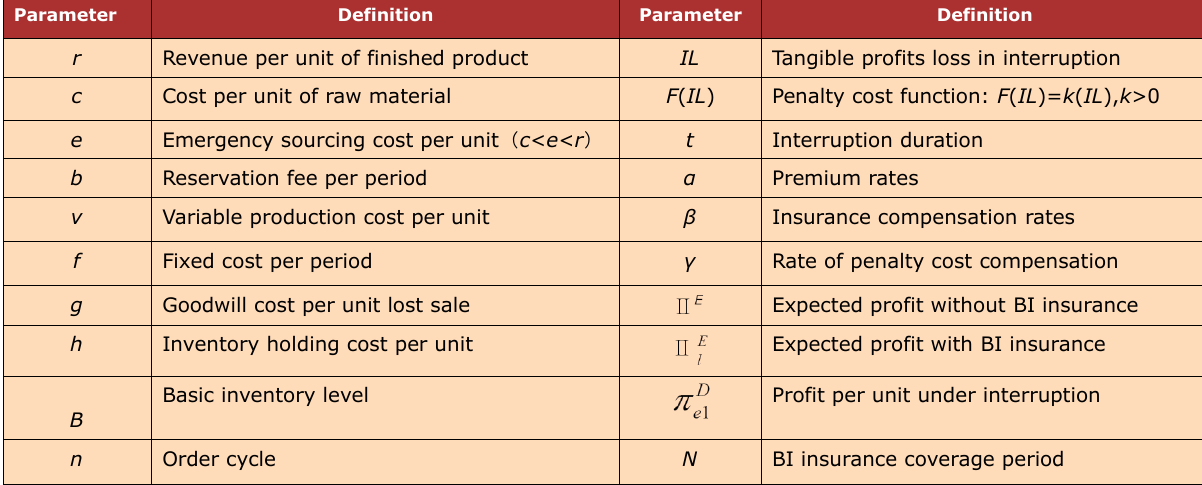
Table 1. Parameters